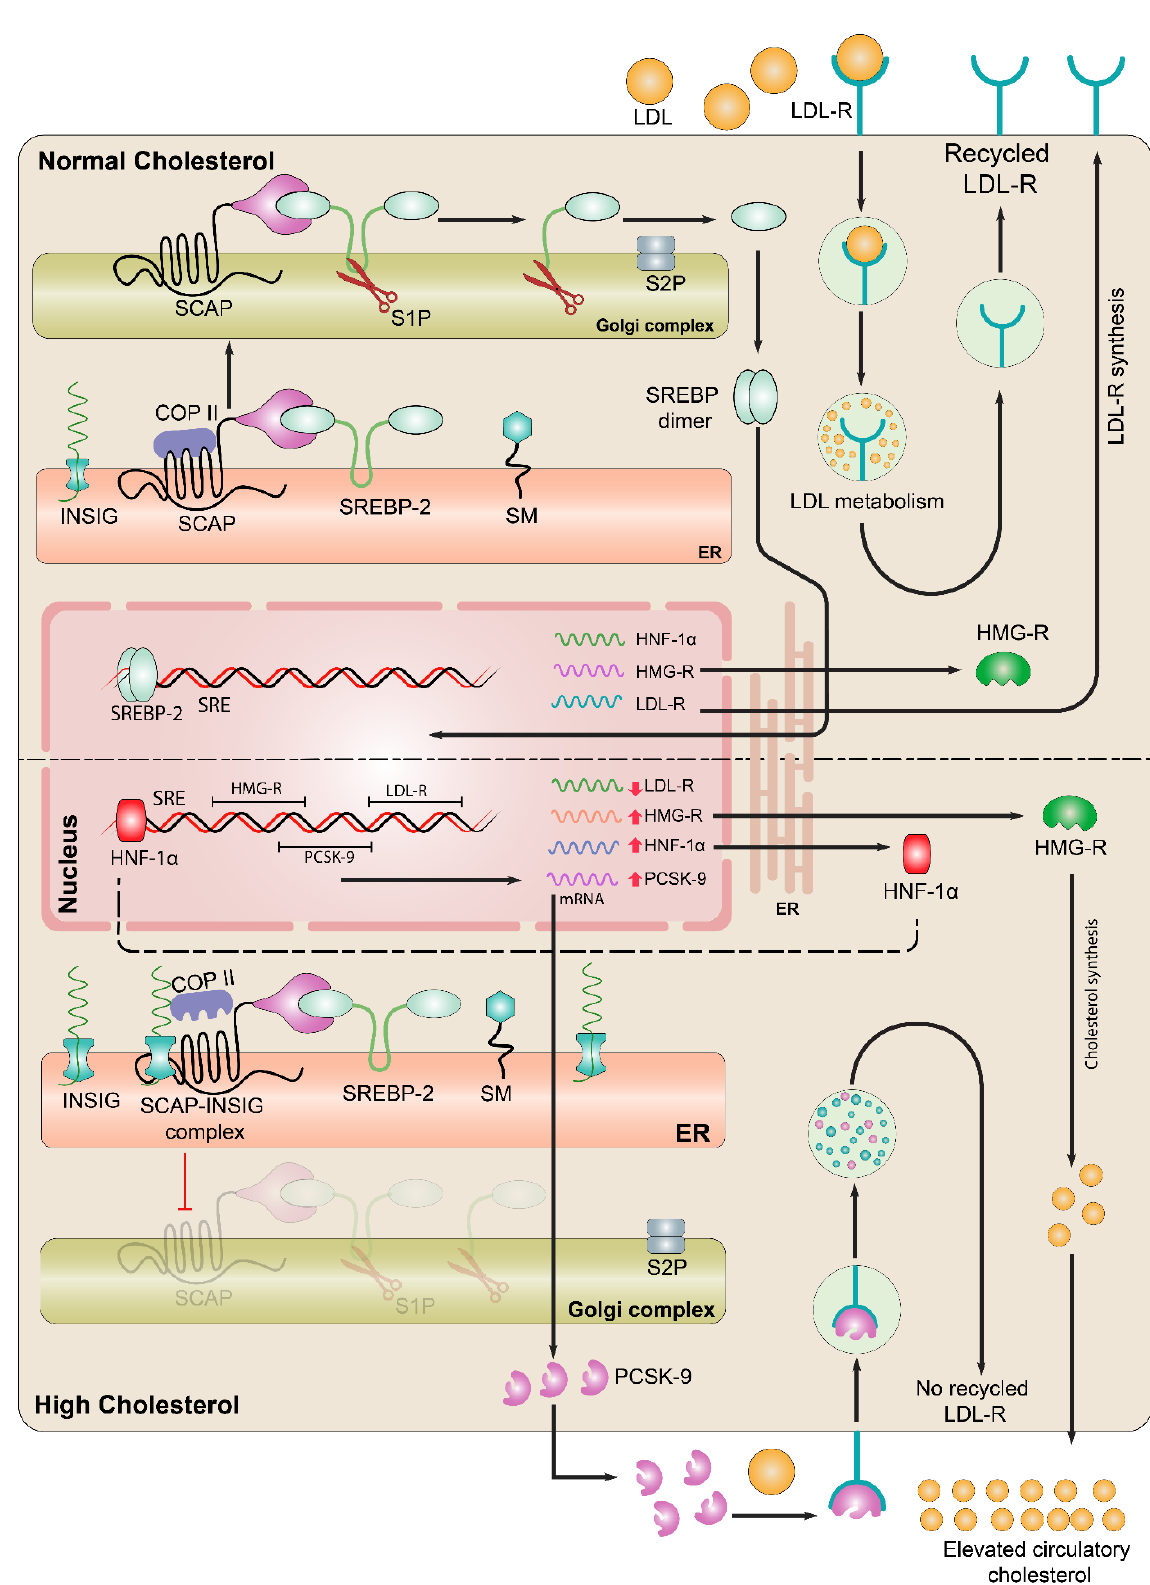
Figure 1: Mechanistic insight into the cholesterol homeostasis: Sterol regulatory element binding protein (SREBP-2) is the key modulator of cholesterol biosynthesis. Endoplasmic reticulum (ER) is in center where SREBP-2 is synthesized but for the activation, its translocation is required to the Golgi. In the ER, SREBP-cleavage activating protein (SCAP) interacts with the SREBP-2. Upper panel: In